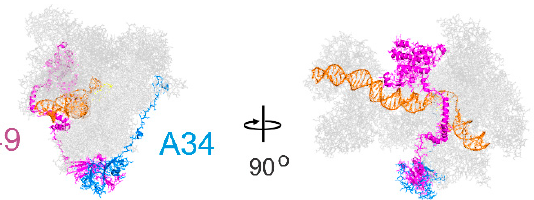
Figure 2. Placement of the RPA34 (blue)–RPA49 (magenta) heterodimer in RNA polymerase I. The DNA is orange, and the remainder of the polymerase subunits are grey. Based on PDB5W66.